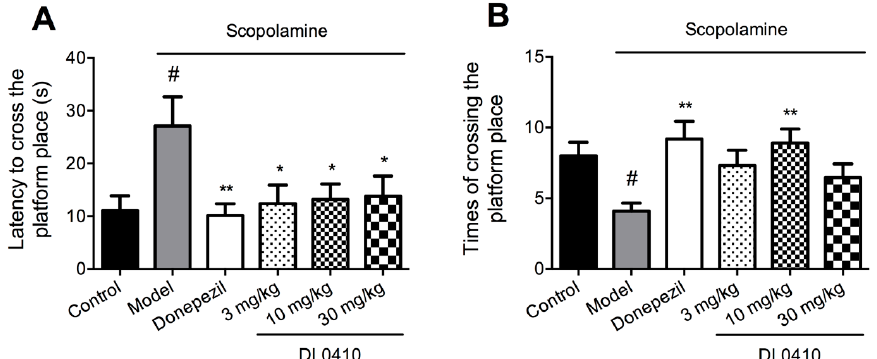
Figure 4. The improvement of DL0410 on the impaired spatial memory induced by scopolamine in the probe trial of the Morris water maze. Data were expressed as mean ± SEM ( n = 12). ( A ) The latency to cross the platform position in the probe trial; ( B ) The times of crossing the platform position in the probe trial. # p < 0.05 vs. the control group; * p < 0.05 and ** p < 0.01 vs. the model group.